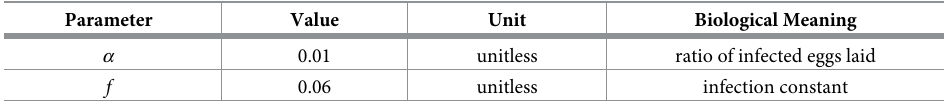
Table 2. Parameters used in La Crosse infection model